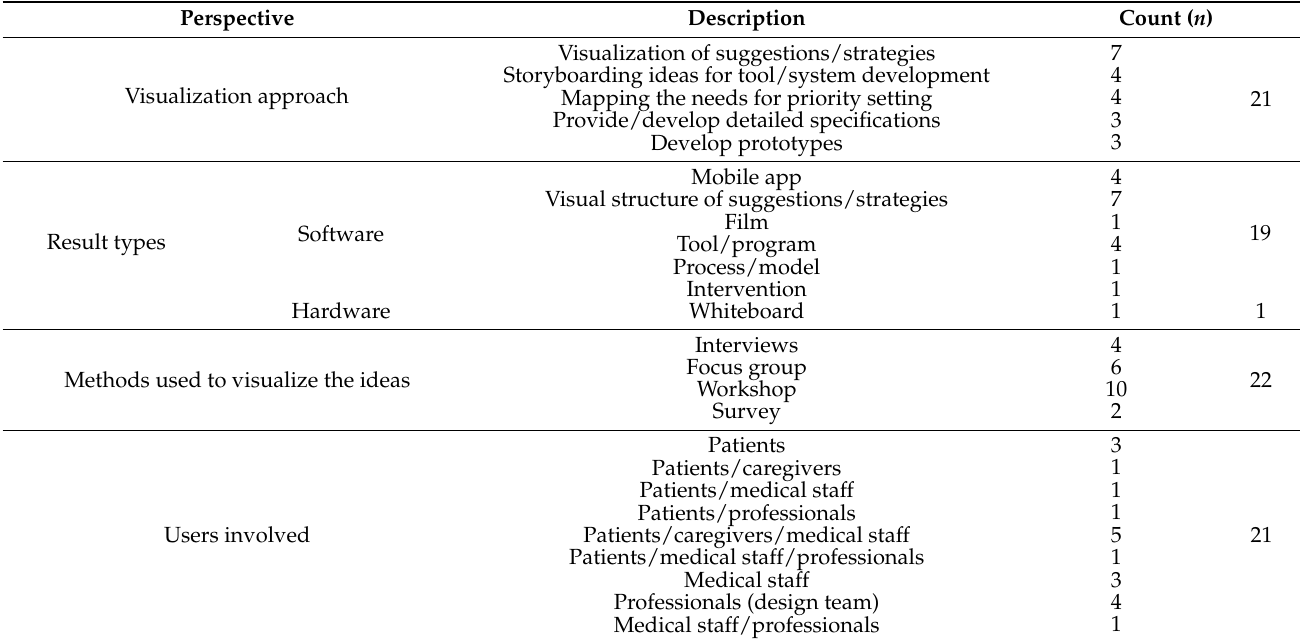
Table 8. Summary of the study’s visualization.